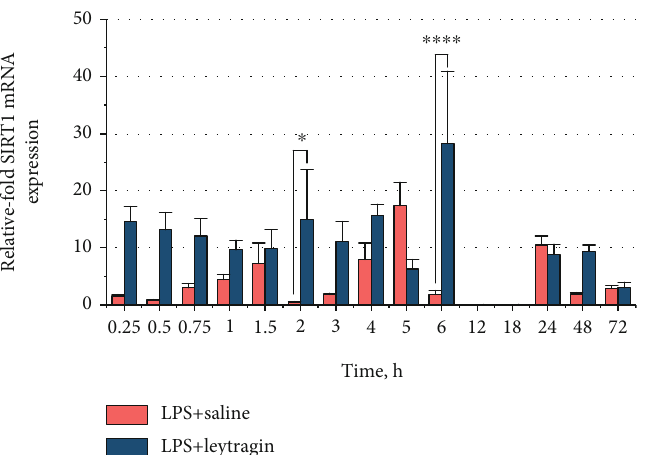
Figure 4: The treatment with leytragin increases SIRT1 mRNA levels in the lungs of LPS-induced mice. The relative levels of SIRT1 mRNA transcription in the lungs of mice that received leytragin were signi fi cantly higher than those in the control group; 75 animals per group were used (5 per indicated time point); ∗ p < 0 : 05 and ∗∗∗∗ p < 0 : 0001 vs. LPS+saline, two-way ANOVA, and post hoc Bonferroni ’ s test (see the text). Bars represent the mean ± SEM .